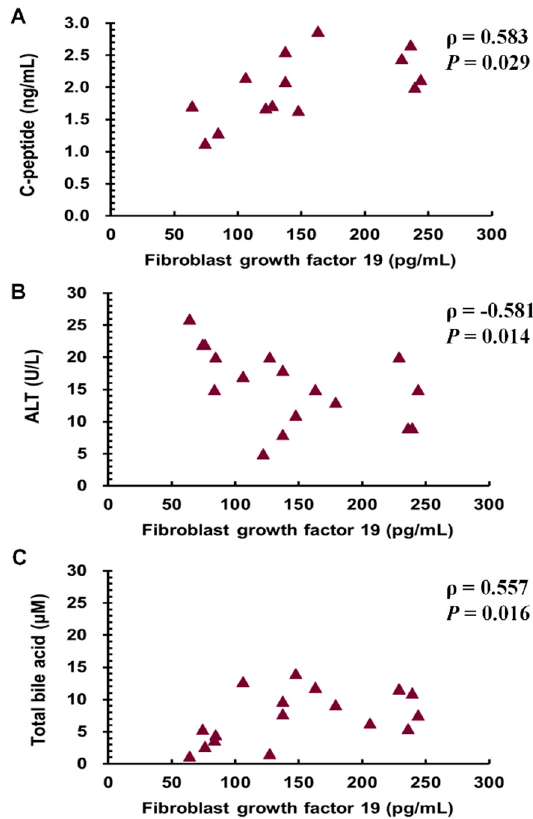
Figure 2. Relationships of the levels of fibroblast growth factor 19 with the levels of C-peptide ( A ), ALT ( B ), and total bile acid ( C ) in the patients with obesity and diabetes mellitus 1 year after sleeve gastrectomy. ALT, alanine aminotransferase.